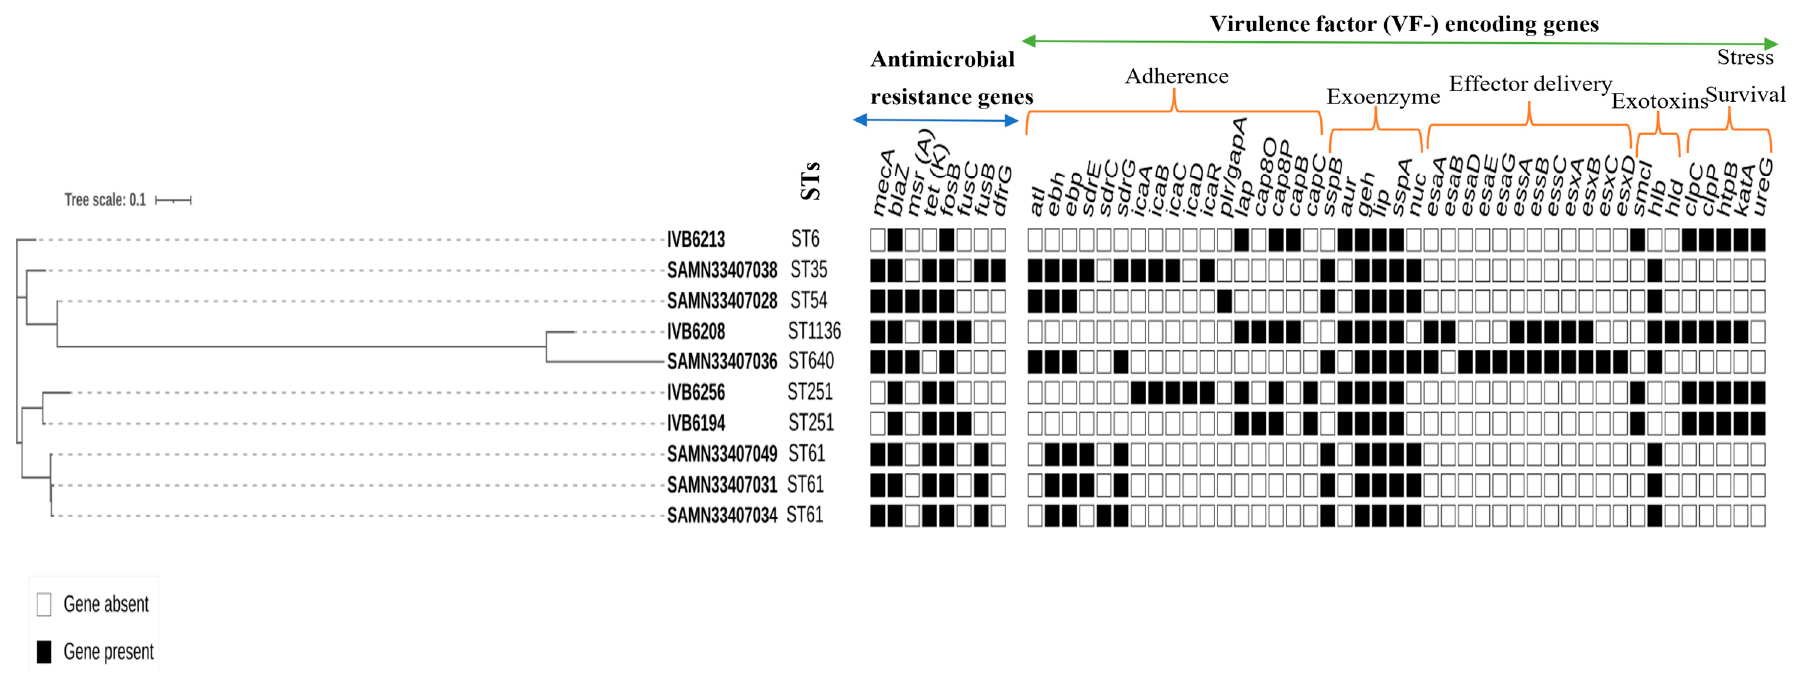
Figure 1. Phylogenetic analysis, antimicrobial resistance, and virulence encoding genes present in camel-derived S. epidermidis. The SNP-based phylogenetic tree was constructed with the strains of this study (SAMN33407028, SAMN33407031, SAMN33407034, SAMN33407036, SAMN33407038, SAMN33407049), and the strains of the previous study by Akarsu et al. (IVB6208, IVB6194, IVB6213, and IVB6256) [38]. Filled shapes indicate the presence of the genes. Empty shapes indicate absence of the genes. Scalebar indicates a genetic distance of 0.1 SNPs per branch.